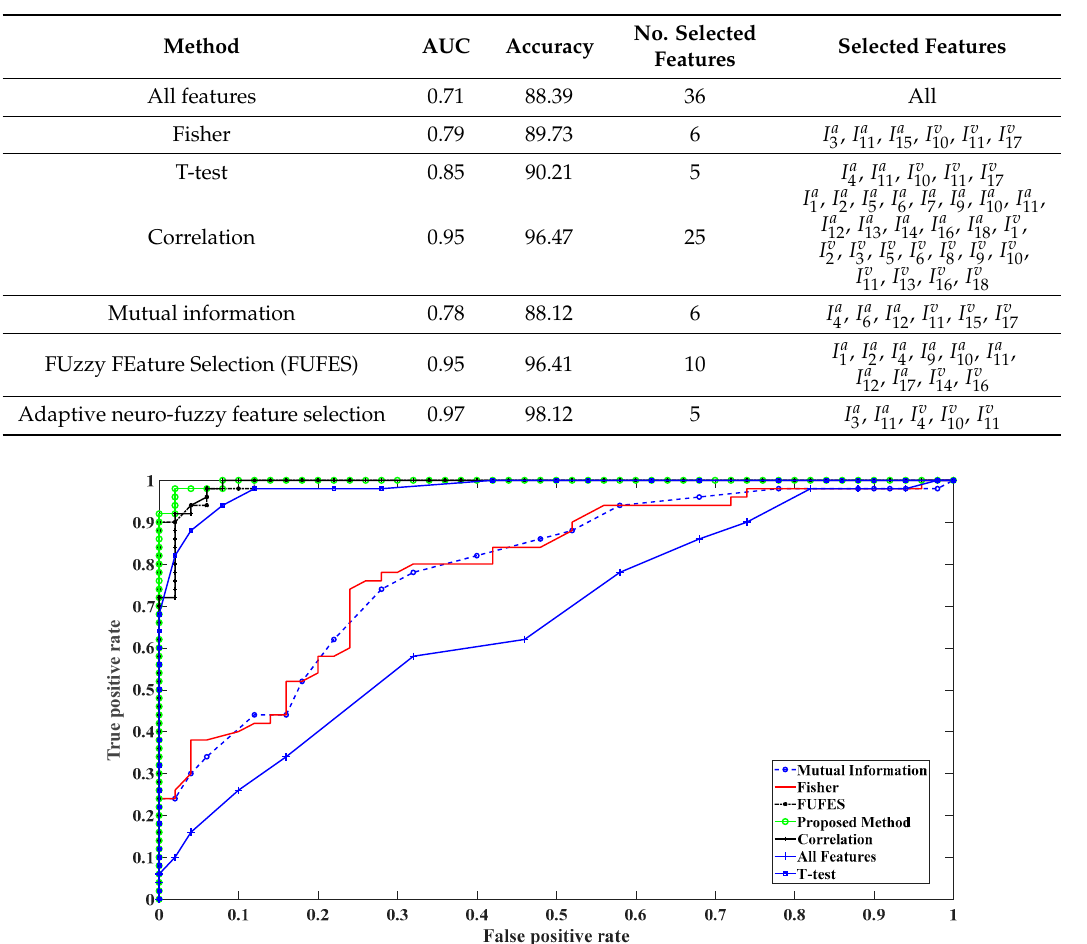
Table 6. Comparison the accuracy of the proposed method with the reported results of non ‐ invasive drowsiness detection system in previous studies.